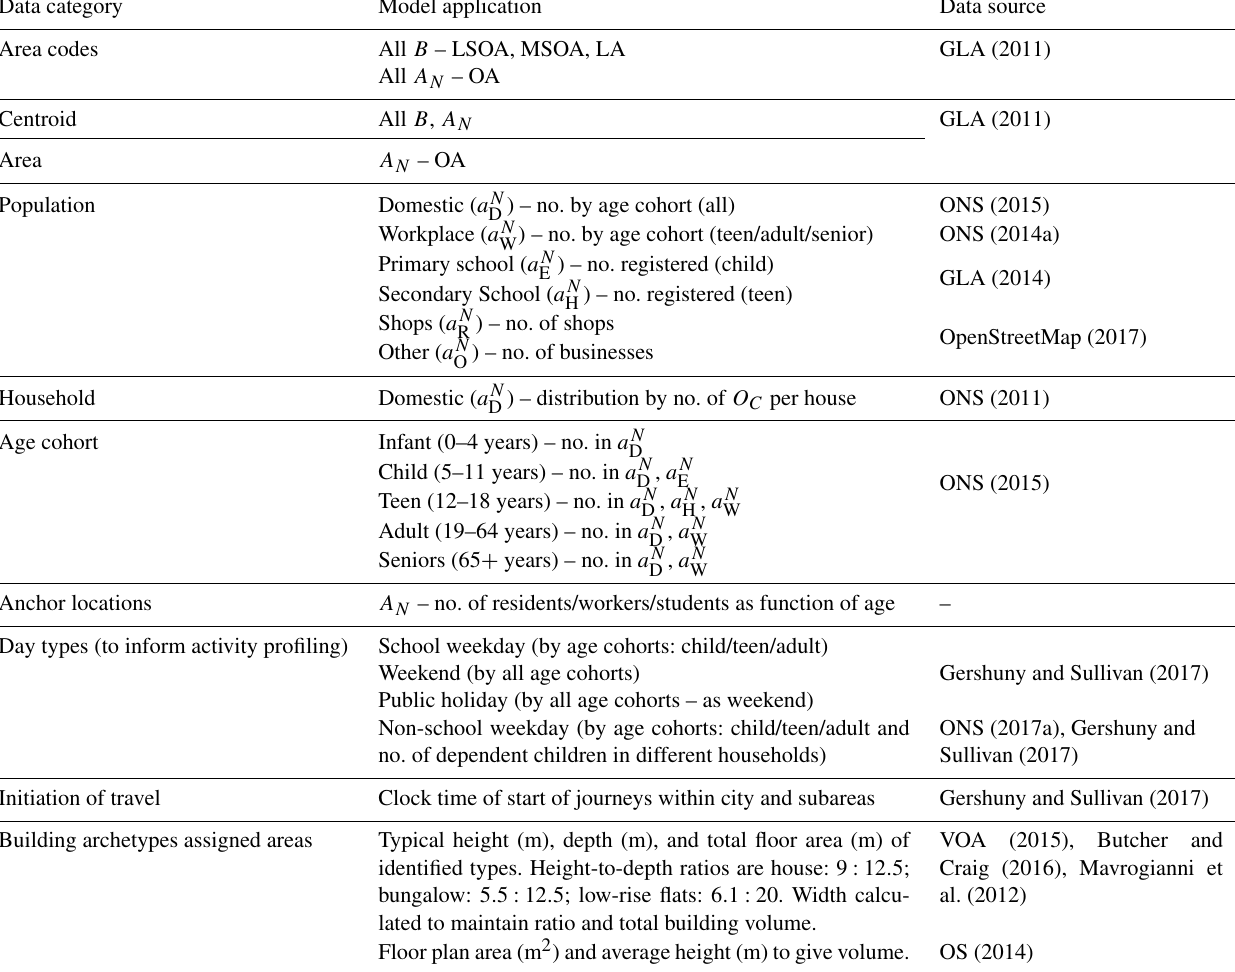
Table 2. Spatial, temporal, and demographic data used to inform activity in Greater London. Data sources: Greater London Authority (GLA), Office for National Statistics (ONS), Chartered Institution of Building Service Engineers (CIBSE), Ordnance Survey (OS), Valuation Office Agency (VOA). See also Table